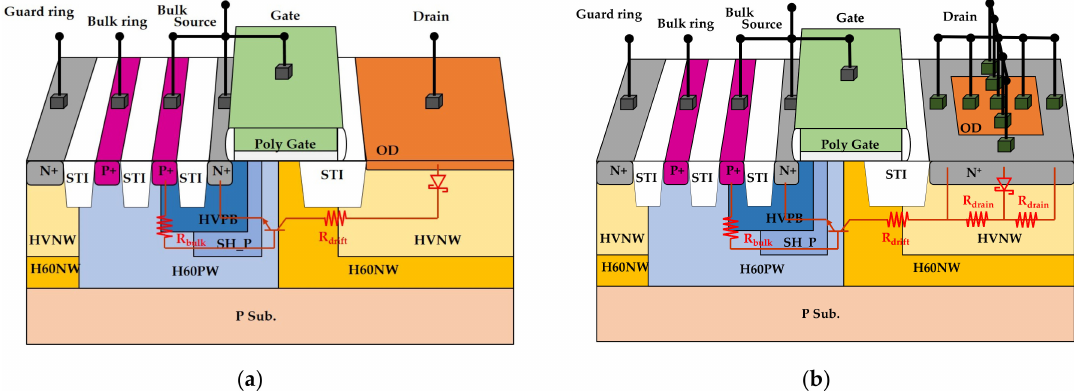
Figure 7. 3D structure views of HV nLDMOS as with ( a ) full removing N + heavy doping, and ( b ) a central-type embedded Schottky diode modulation in the drain